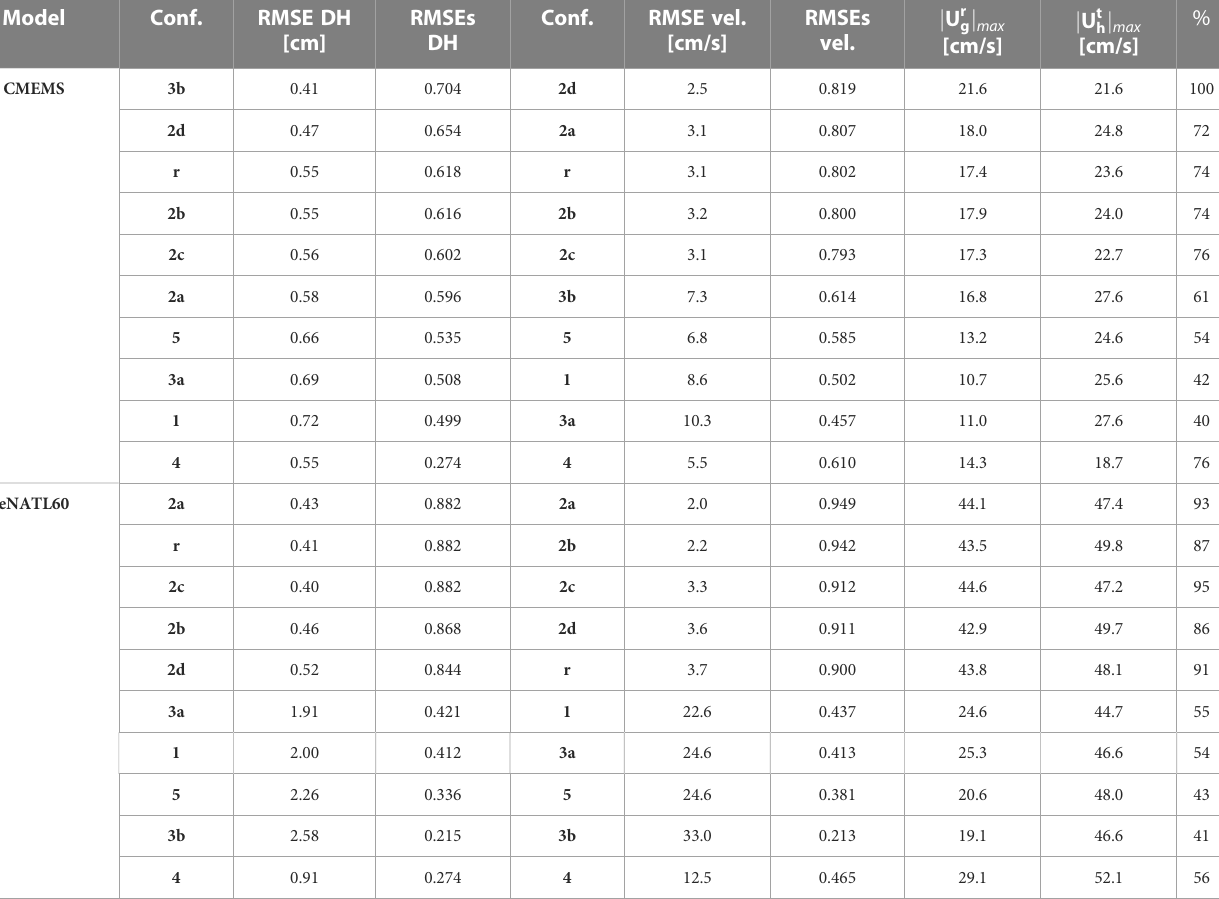
TABLE 4 Statistics for the con fi gurations simulated in the Atlantic from two different models: CMEMS global reanalysis and eNATL60. Model Conf. RMSE DH RMSEs [cm] DH